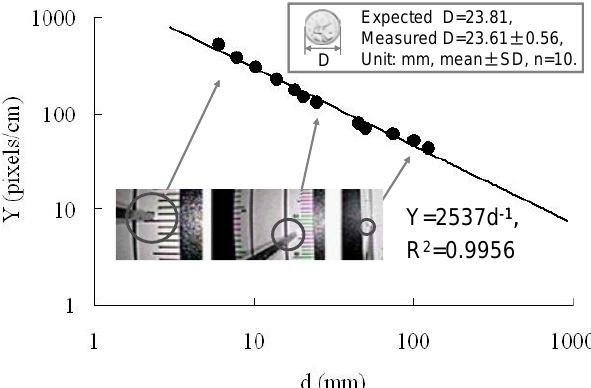
Fig. 2. The relationship between the conversion factor ( Y ) and the distance ( d ) of the CCD camera on the scope tip from the object to be imaged. The conversion factor Y was de¯ned as the ratio of the image size or number of pixels to its actual metric size of an object that was imaged. The image size varied depending on the distance from which the object was imaged as demonstrated by the images in the lower insert. In the case of the nasopharyngoscope used in this study, Y decreased with increasing d as a power-law function, represented by the solid line that closely ¯tted the measurement